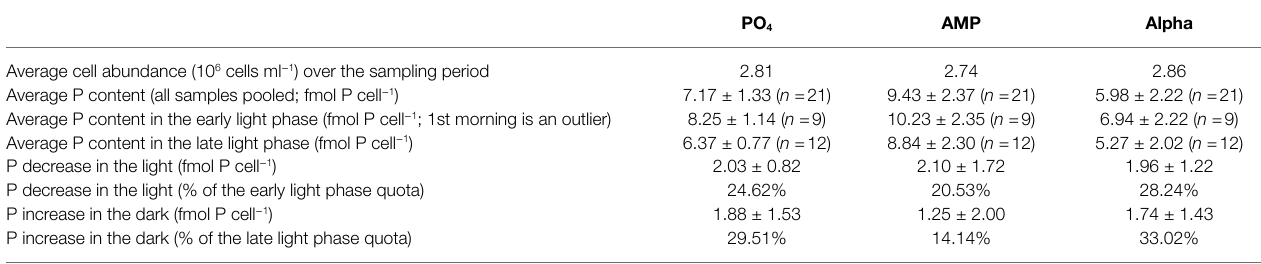
TABLE 4 | Particulate phosphorus content normalized per cell, measured in exponentially growing cultures of Crocosphaera watsonii provided with either an inorganic (PO